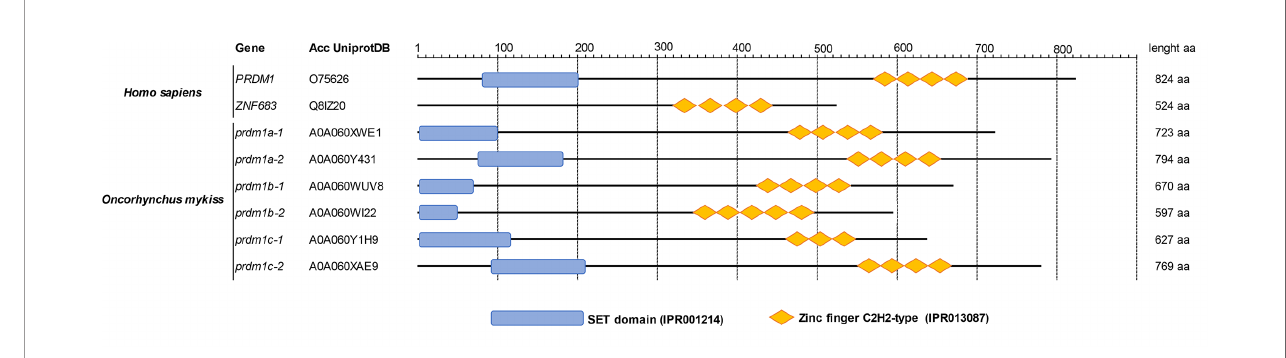
FIGURE 1 | Analysis of conserved domains according InterPro database. The amino acid sequences of human PRDM1 and ZNF683 as well as those of Prdm1-like proteins from O. mykiss were compared with InterProDB to identify different conserved domains. All proteins showed homology with several tandem zinc fi nger C2H2-type domains at the C-terminus and a SET domain at the N-terminus with the exception of ZNF683, which does not present a